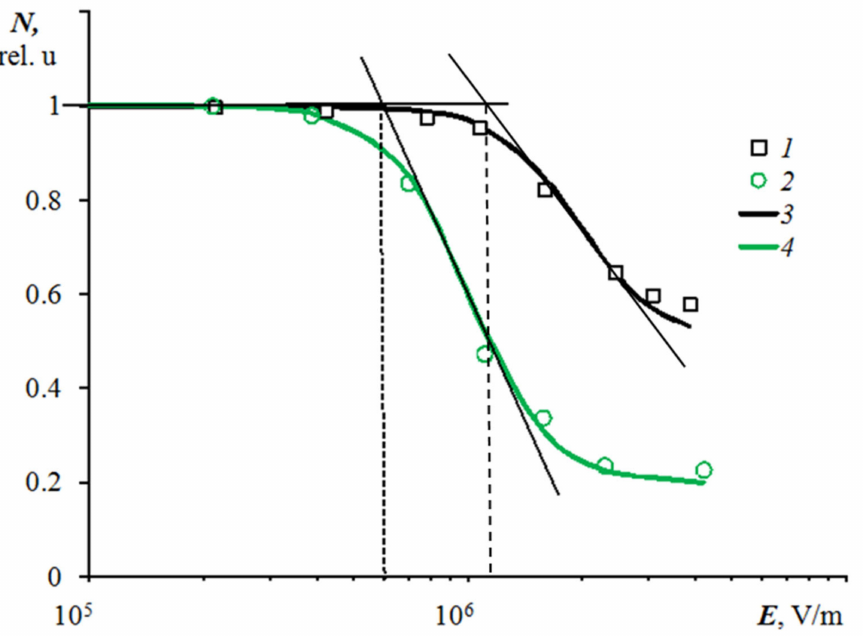
Figure 4. Dependence of the concentration of drops on the surface N on the strength of the external electric field E . (1)—the average radius of the drops is 0.06 mm, (2)—0.16 mm. (3) and (4) are approximating curves for (1) and (2), respectively.